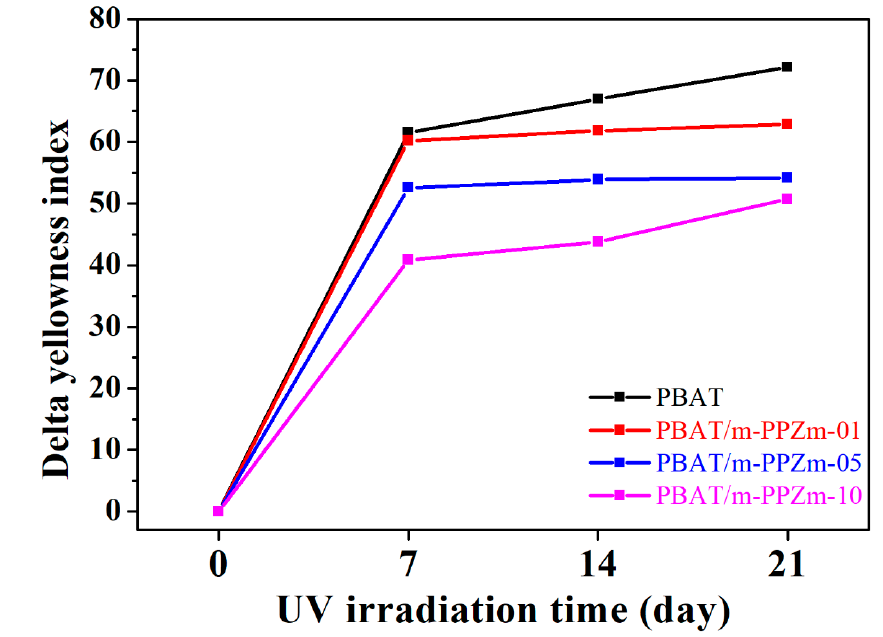
Figure 9. Delta yellowness index of PBAT and PBAT / m-PPZn composites after 21 days of UV